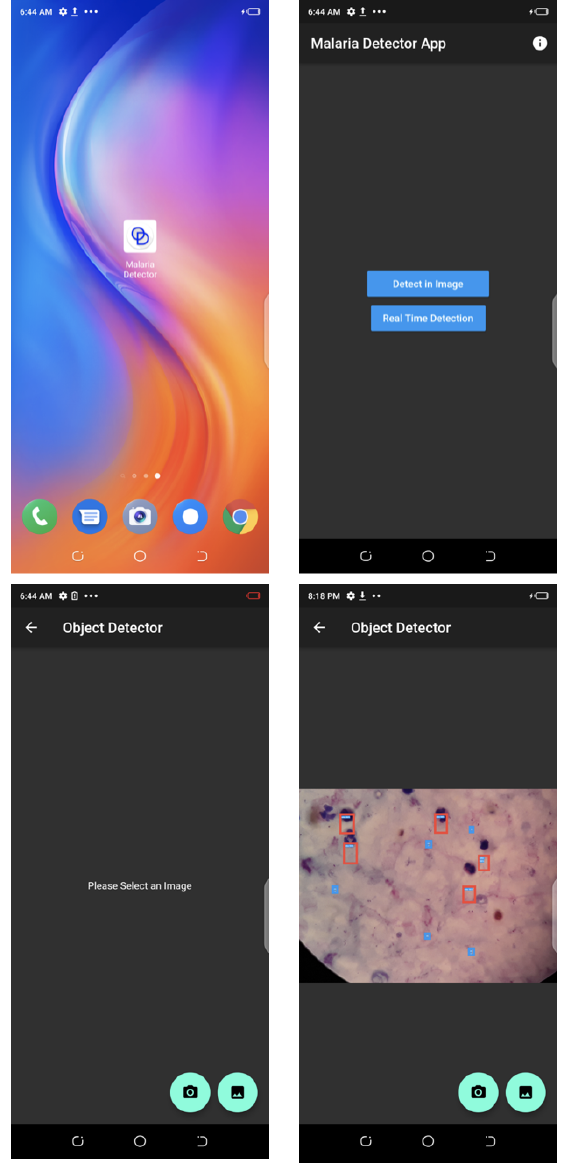
Figure 9. Malaria detection application on Android